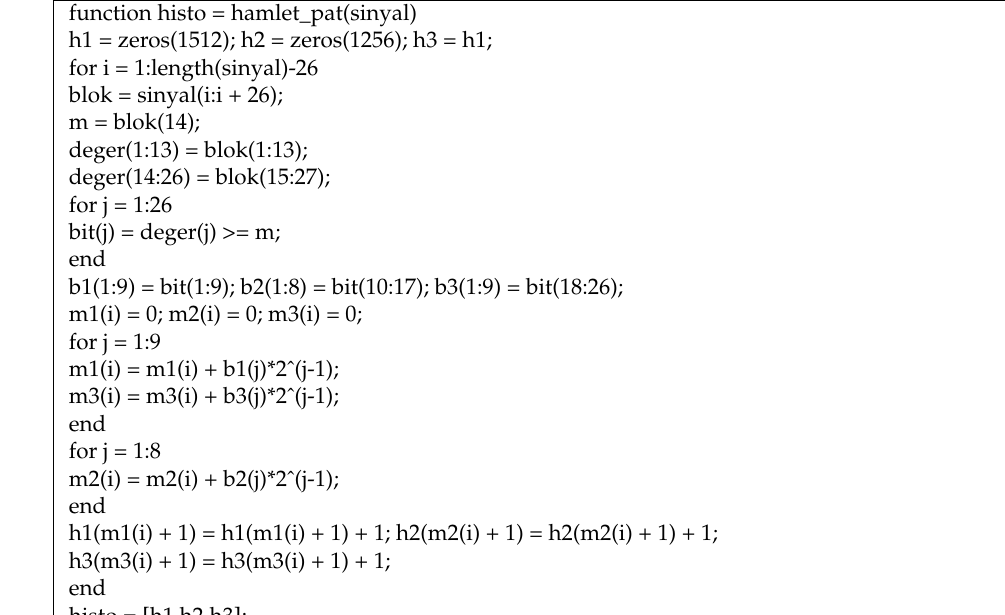
Table A2. The proposed